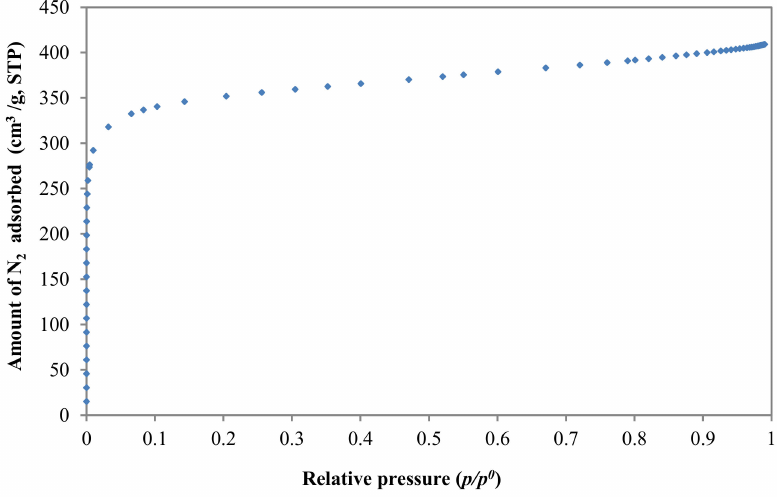
Figure 2. Adsorption isotherm of N 2 at − 196 ◦ C for the synthetized adsorbent.